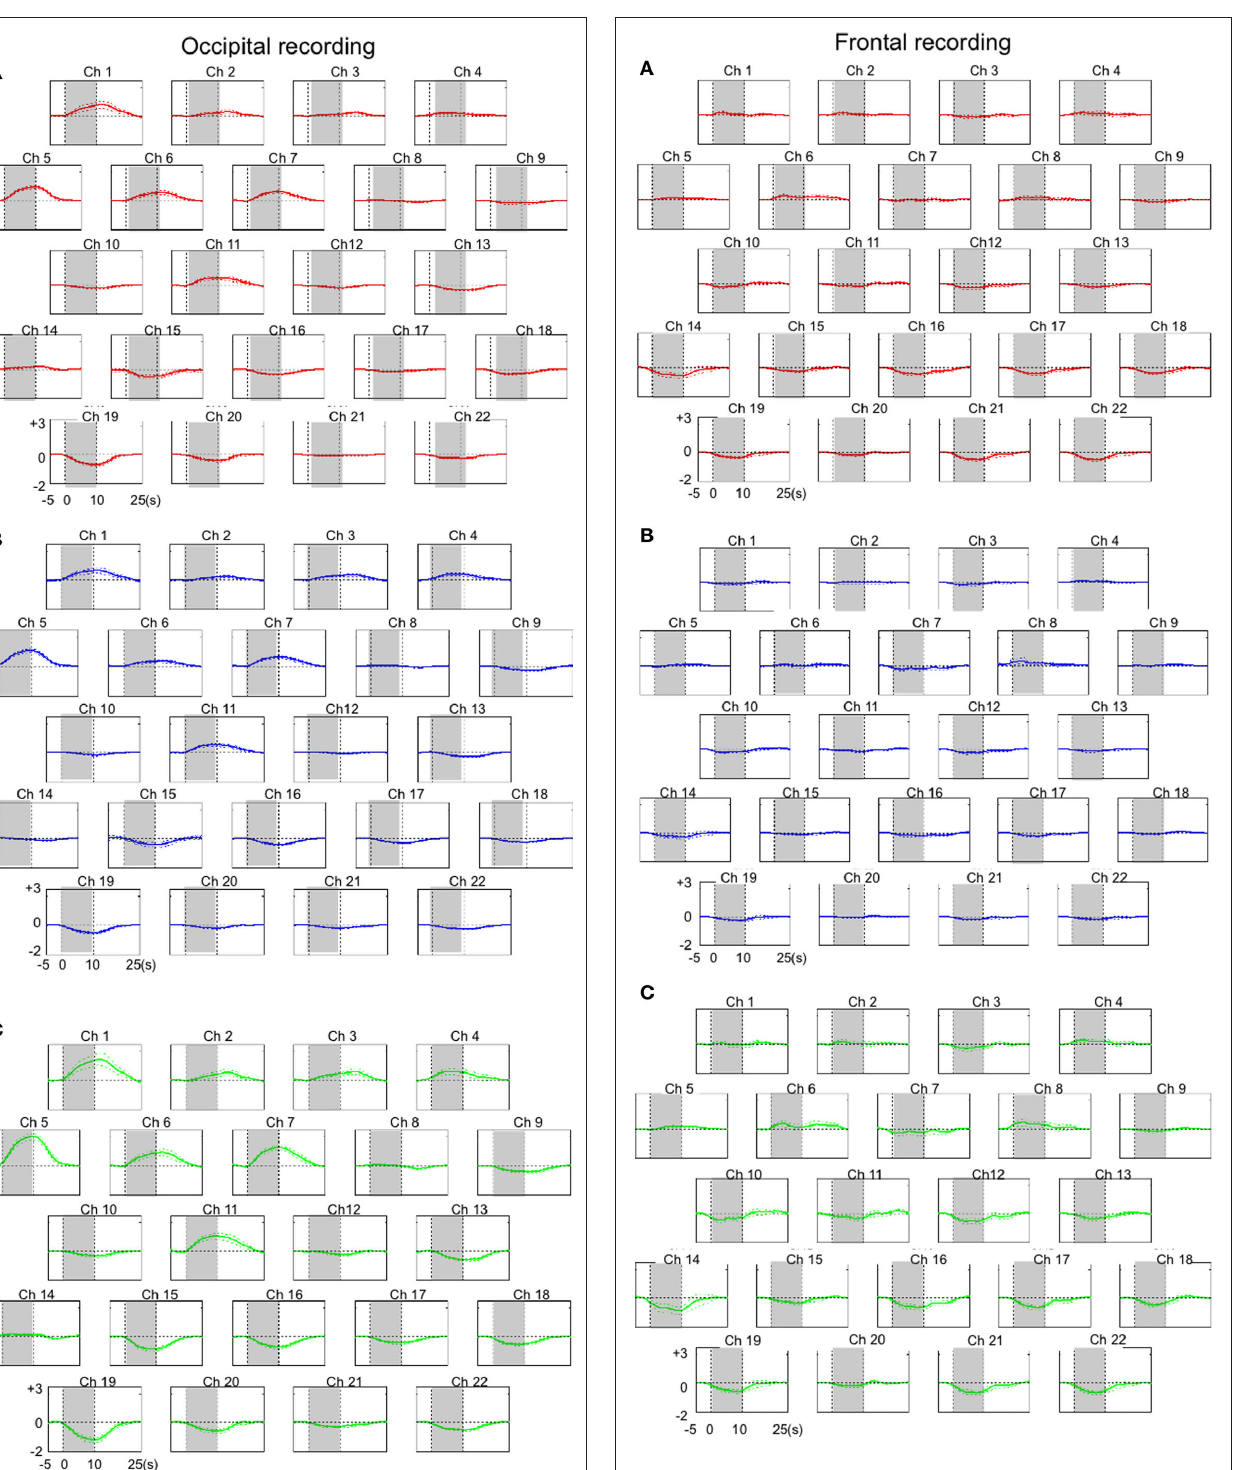
Figure 4 | The results of hemodynamic changes observed for 22 frontal cortical channels (Ch). Averaged hemodynamic changes ( ± SE) for oxy-Hb (A) , deoxy-Hb (B), and total-Hb (C) . Hemodynamic changes were averaged over eight trials. Channels with relatively small numbers were located in more anterior portions of the recorded area. Shades indicate a 10-s stimulation period. Units of hemodynamic change are given as mmol-mm.